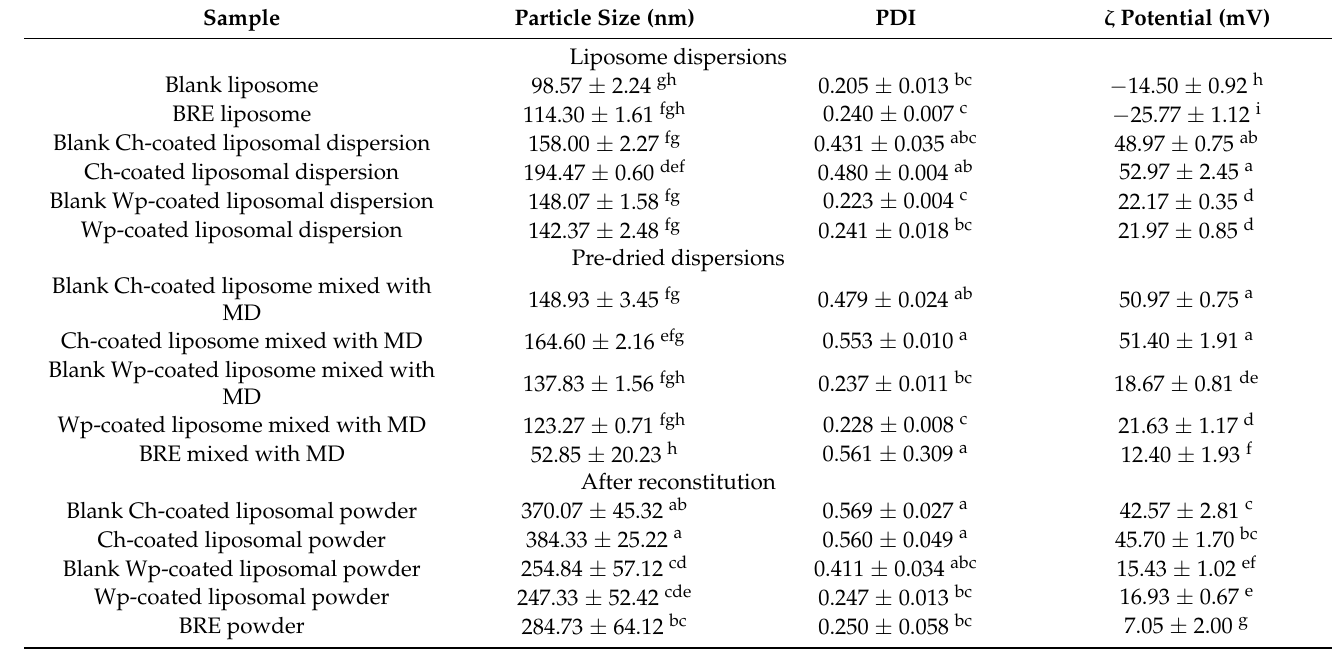
Table 5. Average particle diameter, polydispersity index (PDI), and ζ potential of unloaded (blank) liposomes and BRE-loaded liposomes coated with chitosan (0.4 w / v %) and whey protein (4.0 w / v %), before and after spray drying (mixed with maltodextrin, 20 w / v